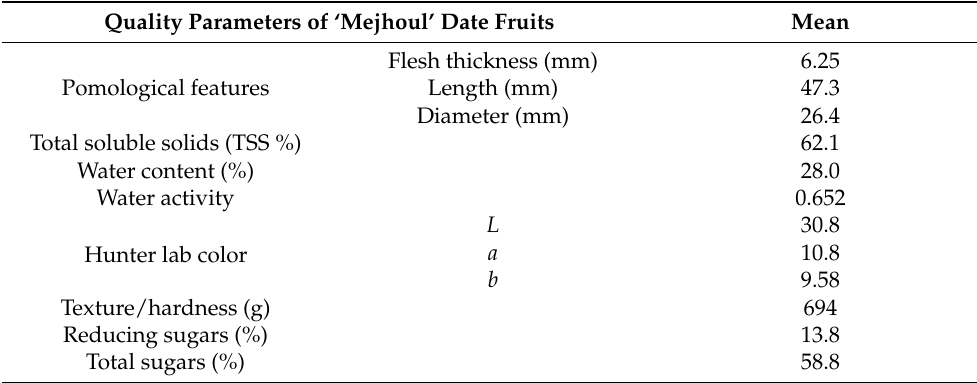
Table 4. Mean values of main quality parameters of ‘Mejhoul’ date